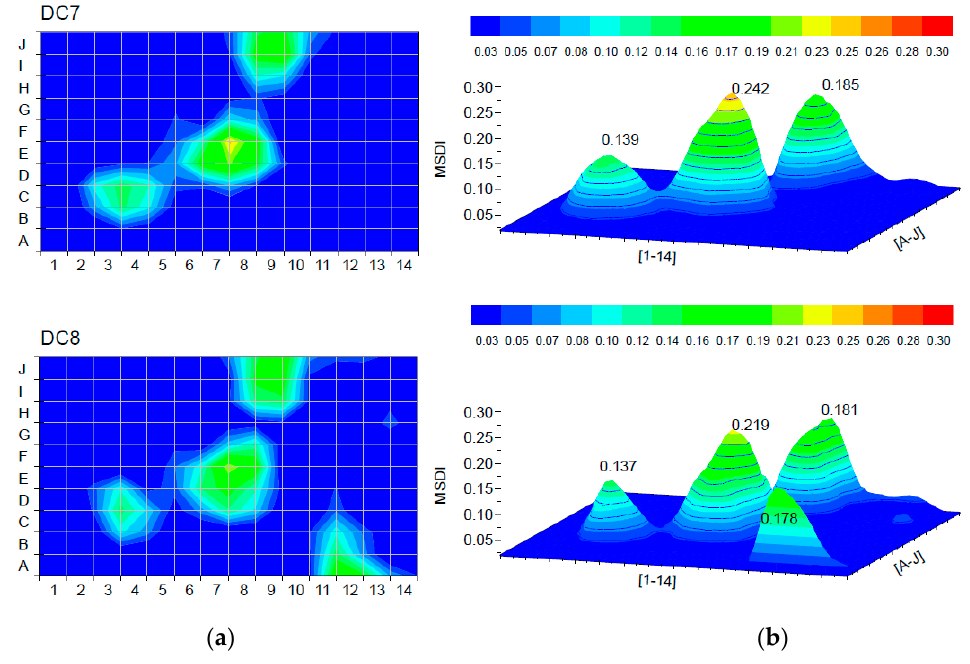
Figure 10. Damage localization for damage cases DC7 and DC8: ( a ) 2D; ( b ) peak values in 3D.